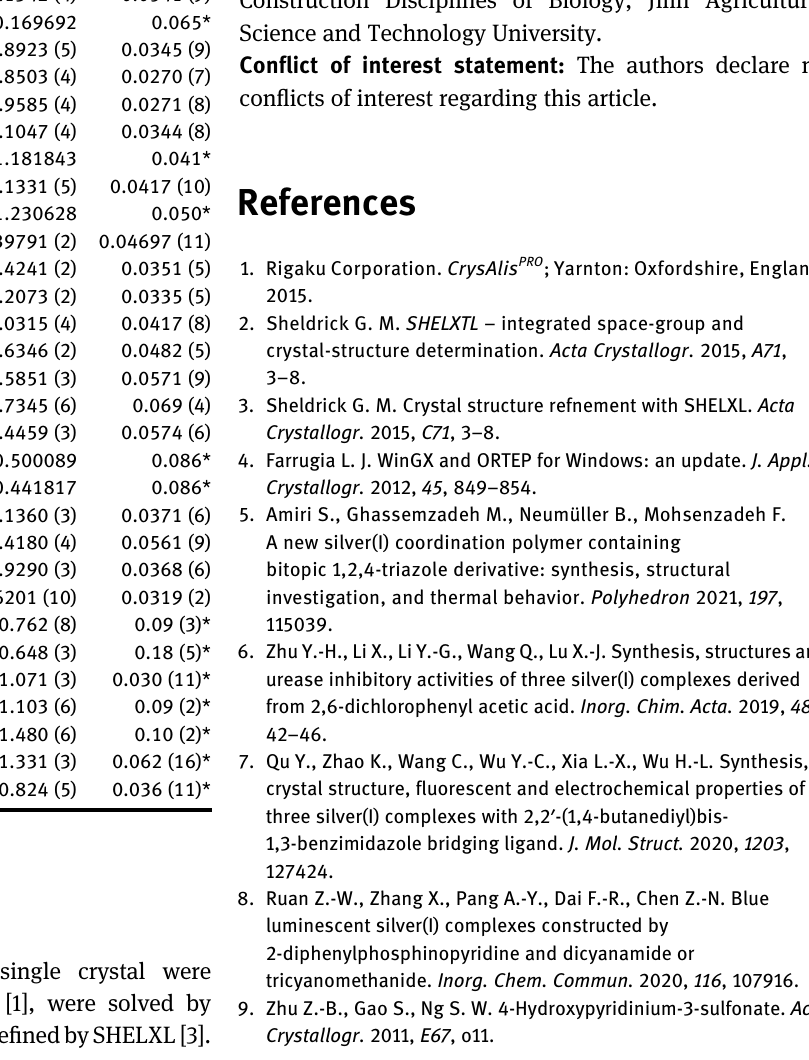
As is depicted in the Figure, the Ag cation is three- coordinated by two nitrogen atoms coming from two 4,4 ′ -bipyridine ligands and one oxygen atom of a water molecule. The bond lengths and angles are similar to those observed in other coordination polymers [5 – 8]. The 4-hydroxypyridine-3-sulfonic acid is the counter ion in this structure. The distance of Ag ⋯ Ag is 3.260 Å. Lastly, the title compound forms a three-dimensional structure due to the existence of free water molecules. It should be mentioned that the structure of the ylidic educt has been reported [9].